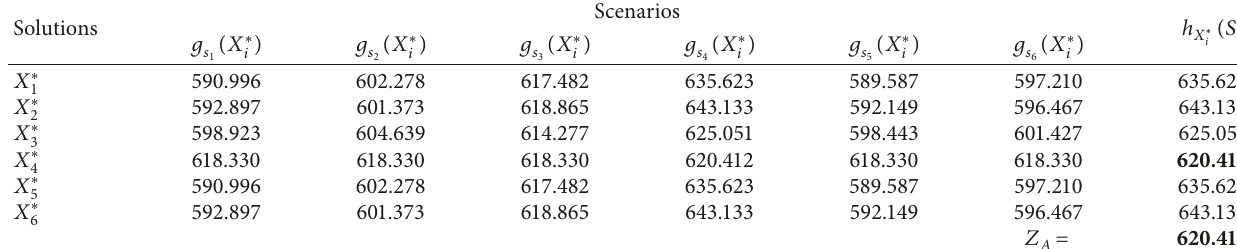
Table 3: The robust deviation Z